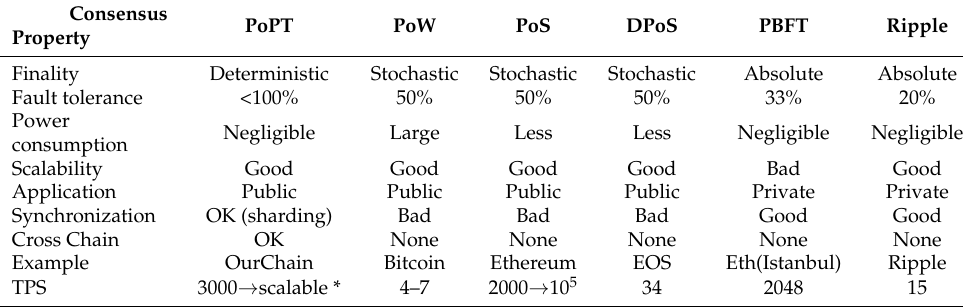
Table 1. Comparison with main consensus